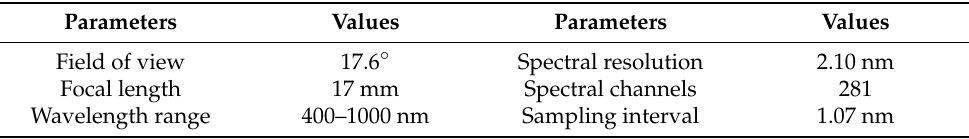
Table 1. Main parameters of the Pika L hyperspectral camera.